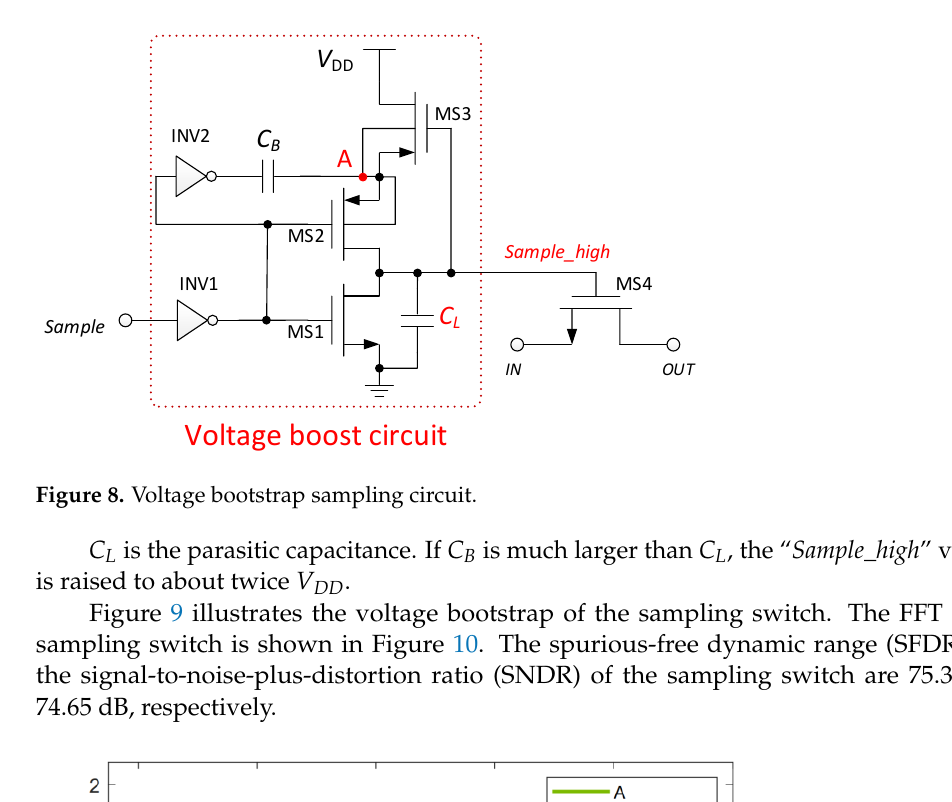
Figure 10. FFT of sampling switch. 2.3. Comparator To decrease the power consumption of the comparator, a two-stage full dynamic comparator [14] is used. Figure 11 shows the schematic diagram of the comparator. The first stage is the dynamic preamplifier stage, and V P and V N are the output signals of the capacitor array DAC, connected to the differential input of the comparator. AN and AP are differential outputs of the dynamic preamplifier stage. The second stage is the